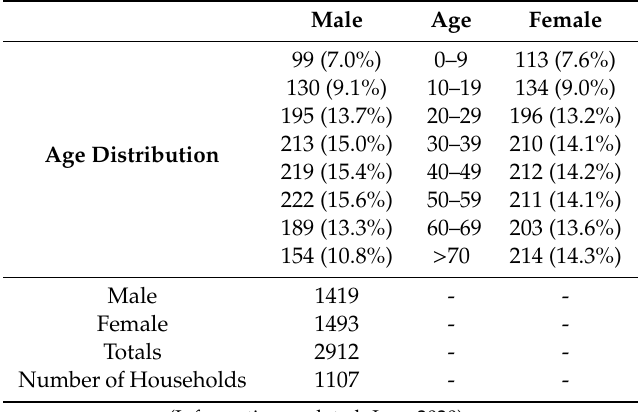
Table 1. Basic information of population in the study area.